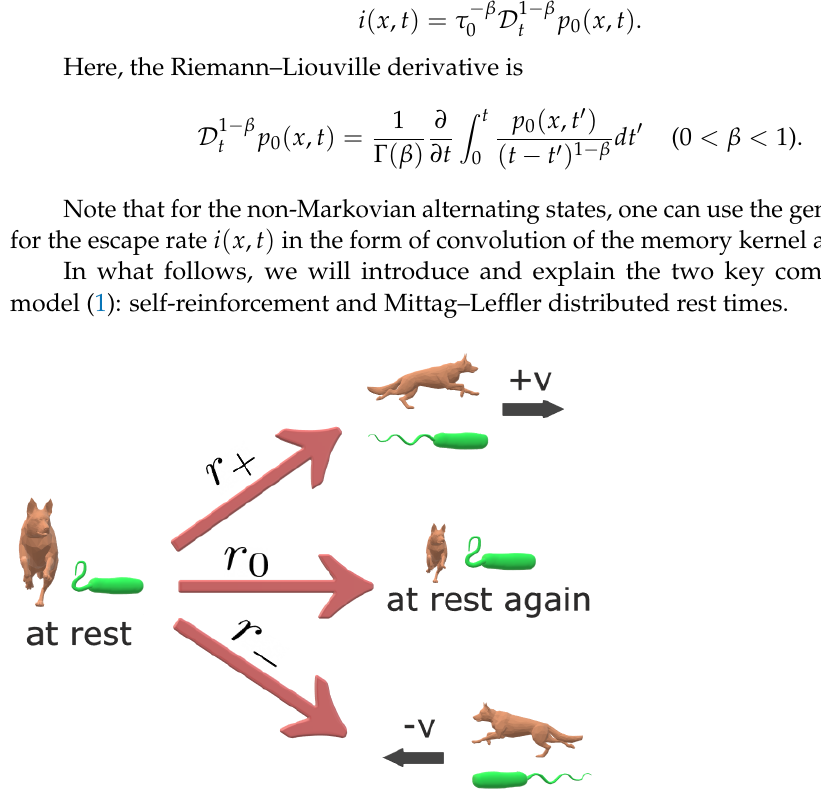
Figure 1. A diagram that shows a dog and a monotrichous bacterium making the decisions to transition from the rest state to the positive velocity, rest and negative velocity states with the associated conditional transition probabilities, r + , r − and r 0 . If the conditional transition probabilities depend on the previous history of choices, r + , r − and r 0 should depend on the current position and